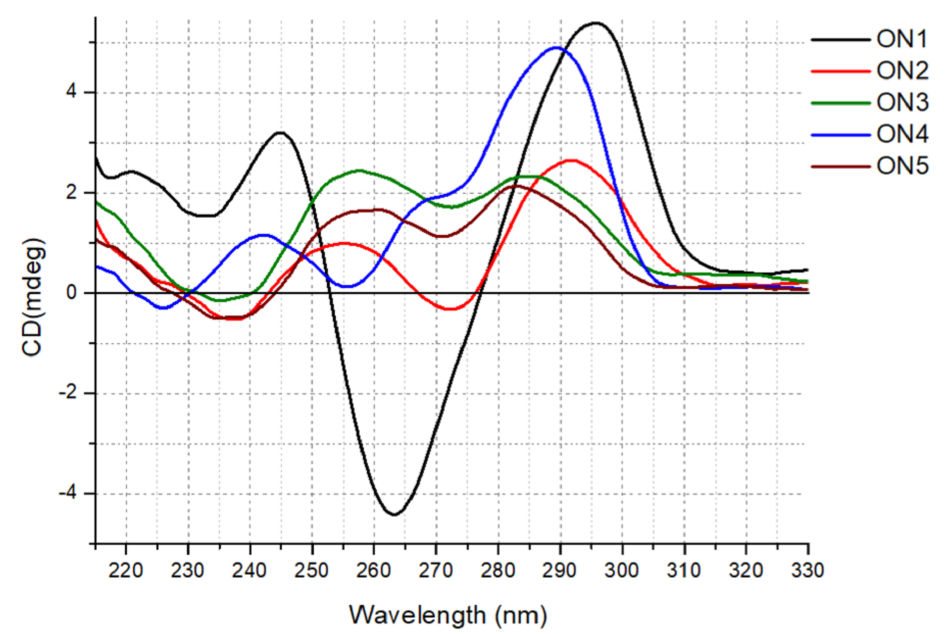
Figure 2. CD spectra of the unlabeled oligonucleotides ON1 to ON5 studied in buffer containing 100 mM KCl, 20 mM sodium cacodylate and 0.5 mM Na2EDTA (pH 7.0) at 37 ◦